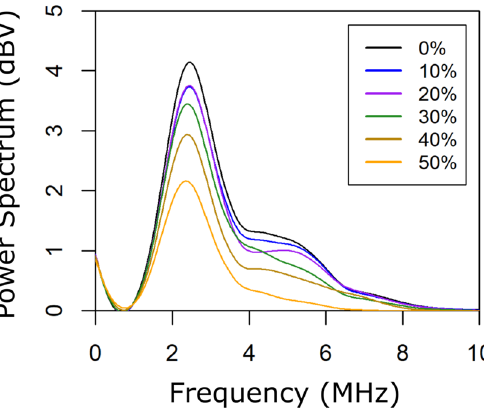
Figure 5. Power spectrum versus frequency for varying sucrose concentration of the fabricated